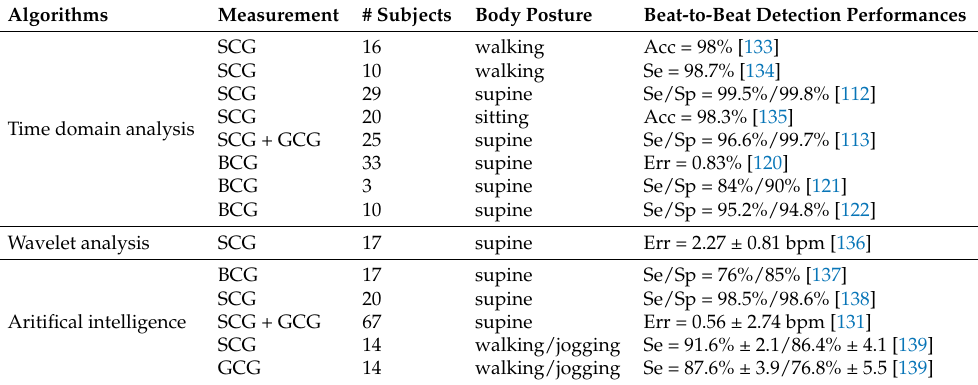
Table 2. Performances on beat-to-beat heart rate estimation of MCG using ECG as reference. Se: sensitivity; Sp: specificity; Acc: accuracy; Err = error. Algorithms Measurement # Subjects Body Posture Beat-to-Beat Detection Performances